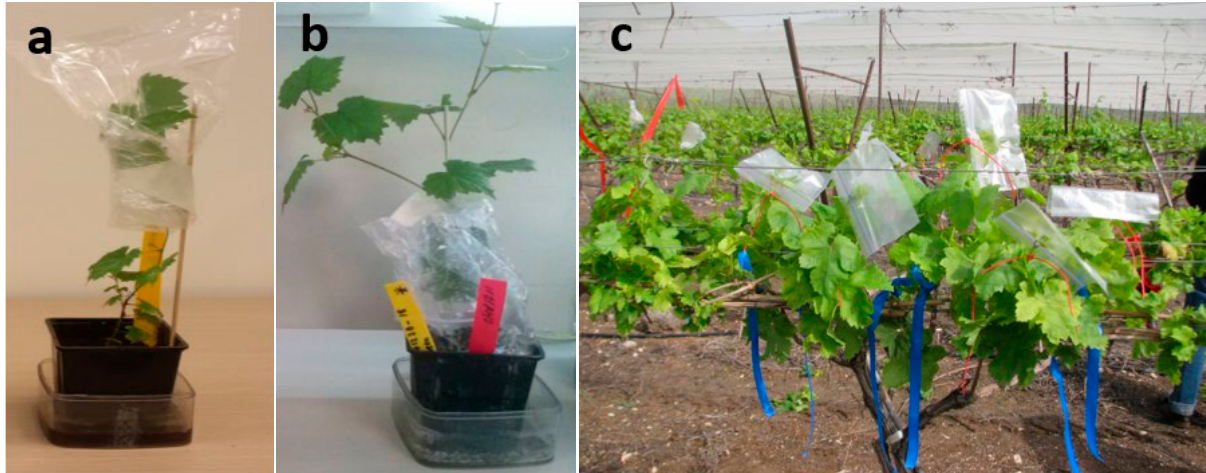
Figure 2. Spraying method. Shoots were partially covered and leaves were sampled 7 d post inoculation from uncovered and covered plant parts. Spray was applied on the shoots of: Lower (a) and upper (b) part of young plants in pots; (c) lower part of mature field grapevine